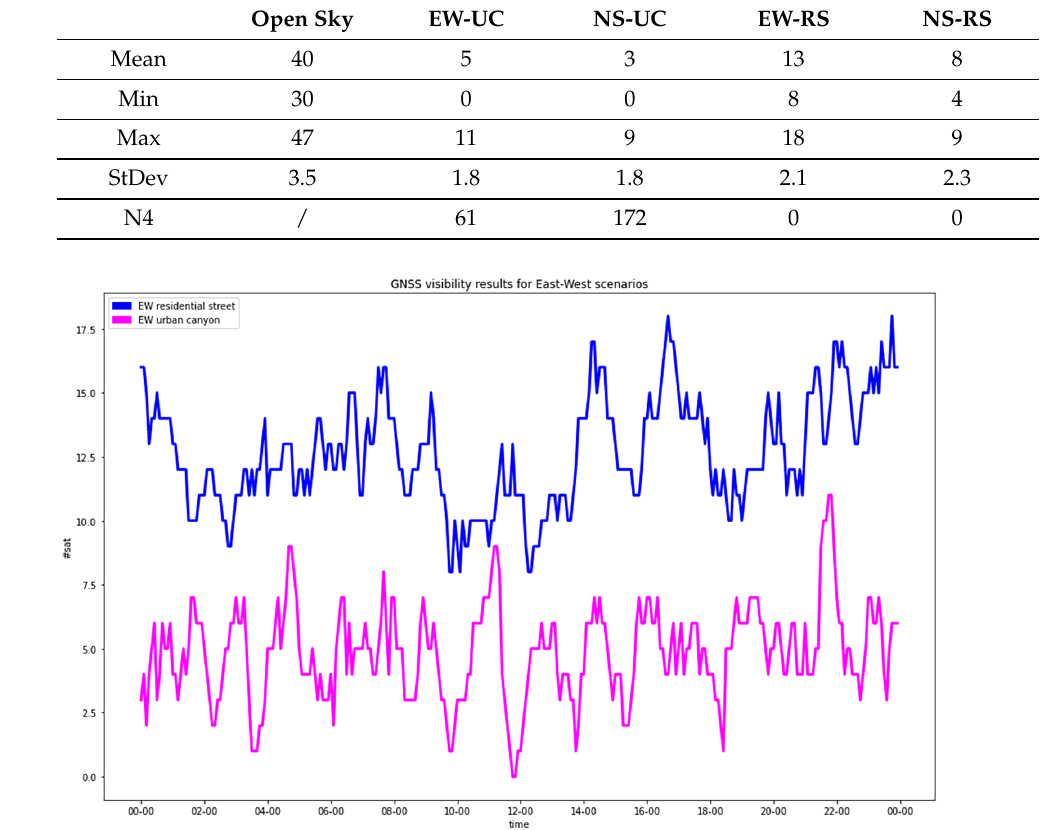
Figure 3. GNSS visibility for east-west streets (blue = RA; pink = UC).